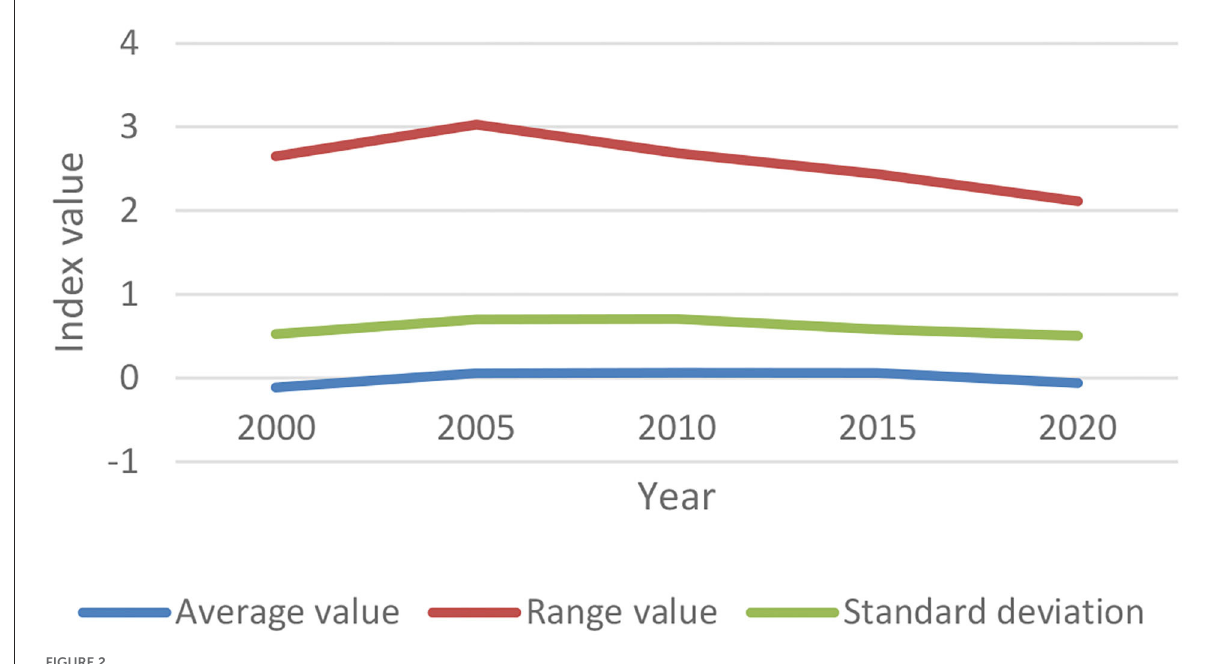
FIGURE2 Evolution of integrated urban-rural development level in the Yangtze River